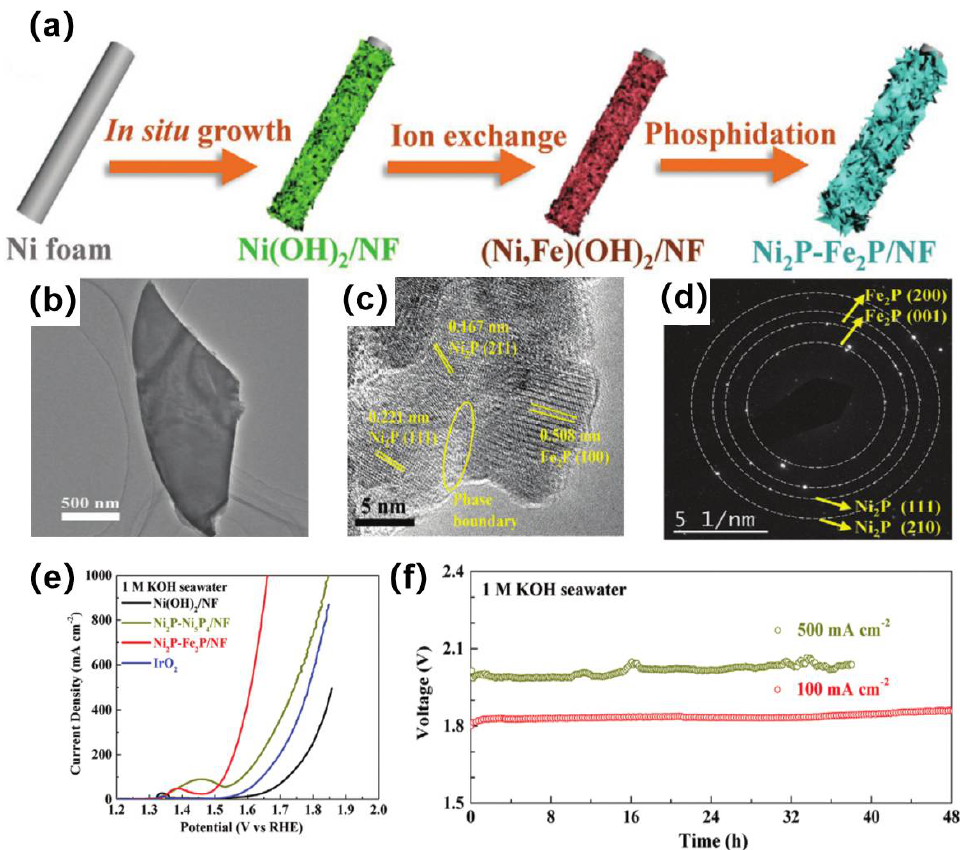
Figure 3. ( a ) Synthesis diagram of Ni 2 P-Fe 2 P/NF, ( b )TEM, ( c ) HRTEM images, ( d ) SAED pattern of a slice of a Ni 2 P-Fe 2 P microsheet, ( e ) OER LSV curves, and ( f ) chronopotentiometric curves of Ni 2 P-Fe 2 P/NF. Reproduced with permission from [60], Copyright © 2020, Wiley-VCH GmbH.